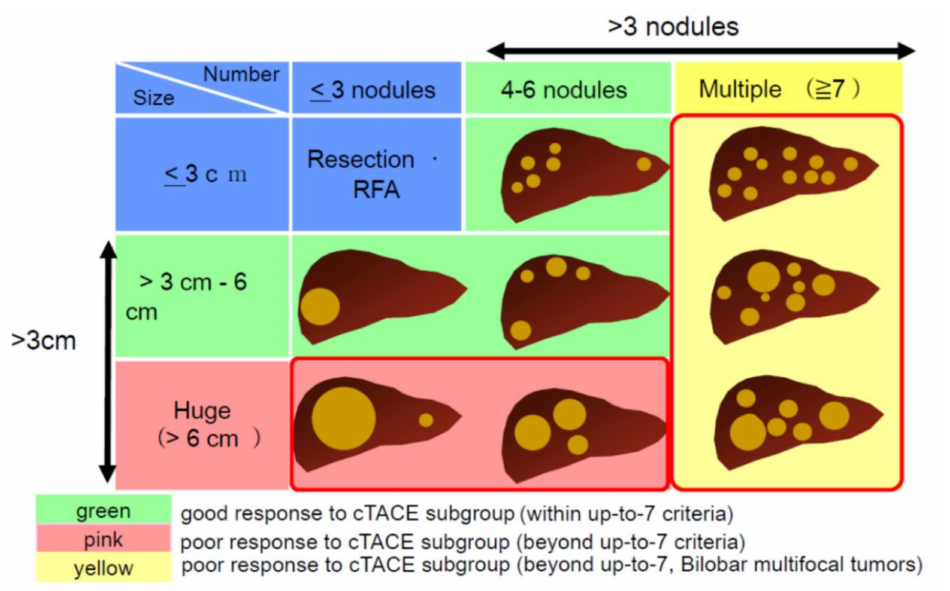
Figure 6. Heterogeneity of intermediate-stage HCC and grade of response to cTACE in each subgroup. Reproduced with permission from Ref. [92]. An Open Access article (CC BY